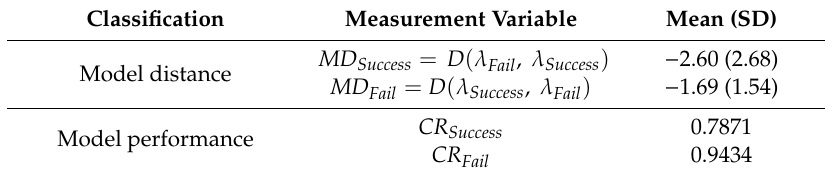
Table 8. Comparison results of two models in terms of model distance and model